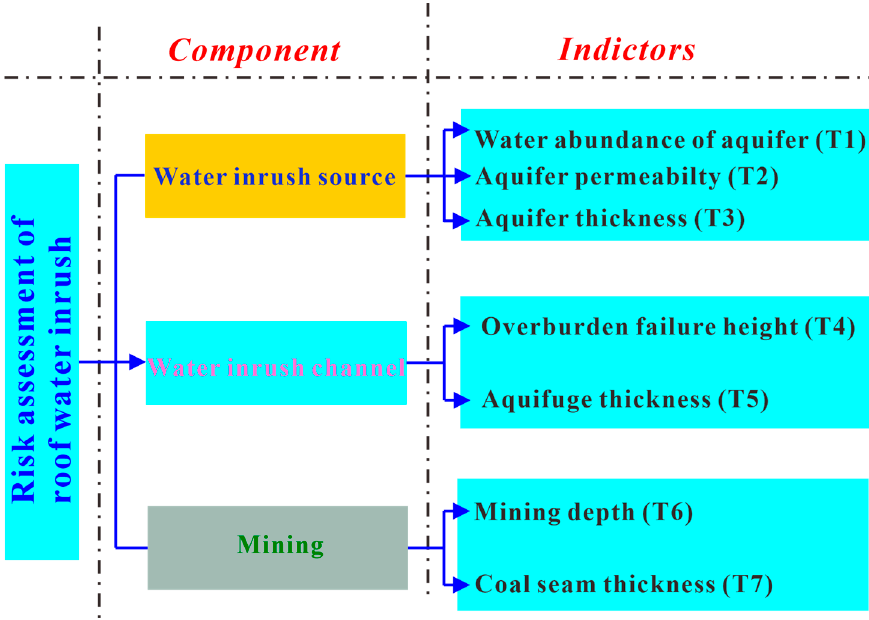
Figure 6. Roof water inrush risk evaluation index system.